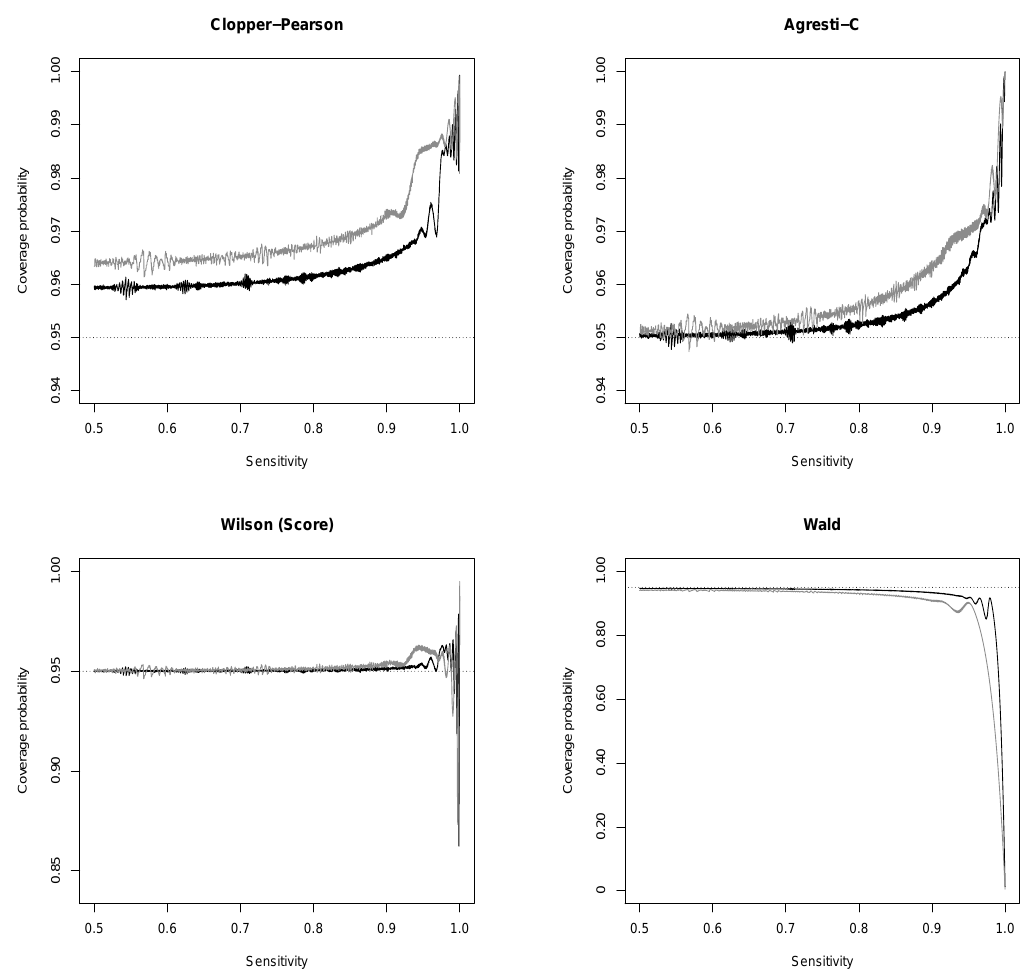
Figure 2. Coverage probability of sensitivity intervals varying with the sensitivity, admitting n = 500, obtained for η = 0.10 (grey line) and η = 0.25 (black line), for Clopper–Pearson (top left), Agresti–Coull (top right), Wilson (bottom left), and Wald (bottom right). The horizontal spotted line marks the nominal confidence level, 95%.